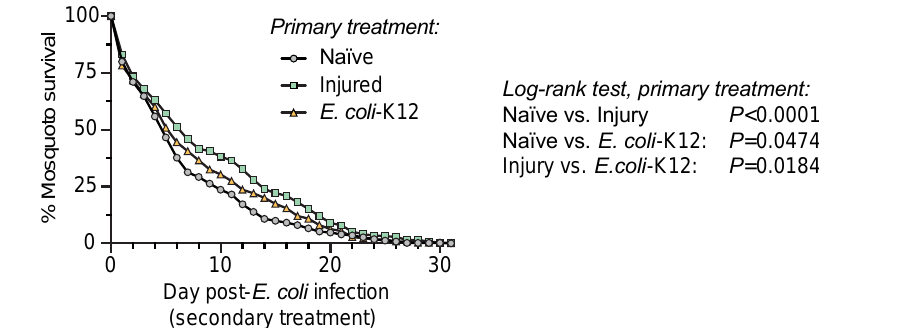
Figure 6. Mosquito survival after the secondary treatment. Five days after the primary treatment of naïve, injury, or infection with E. coli -K12, all the mosquitoes were infected with E. coli -GFP and their survival was tracked every day until all the mosquitoes had died.